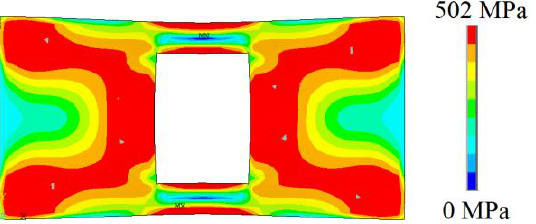
Figure 17. The von Mises stress distribution for the plate with rectangular hole made of Al 7075- T651.